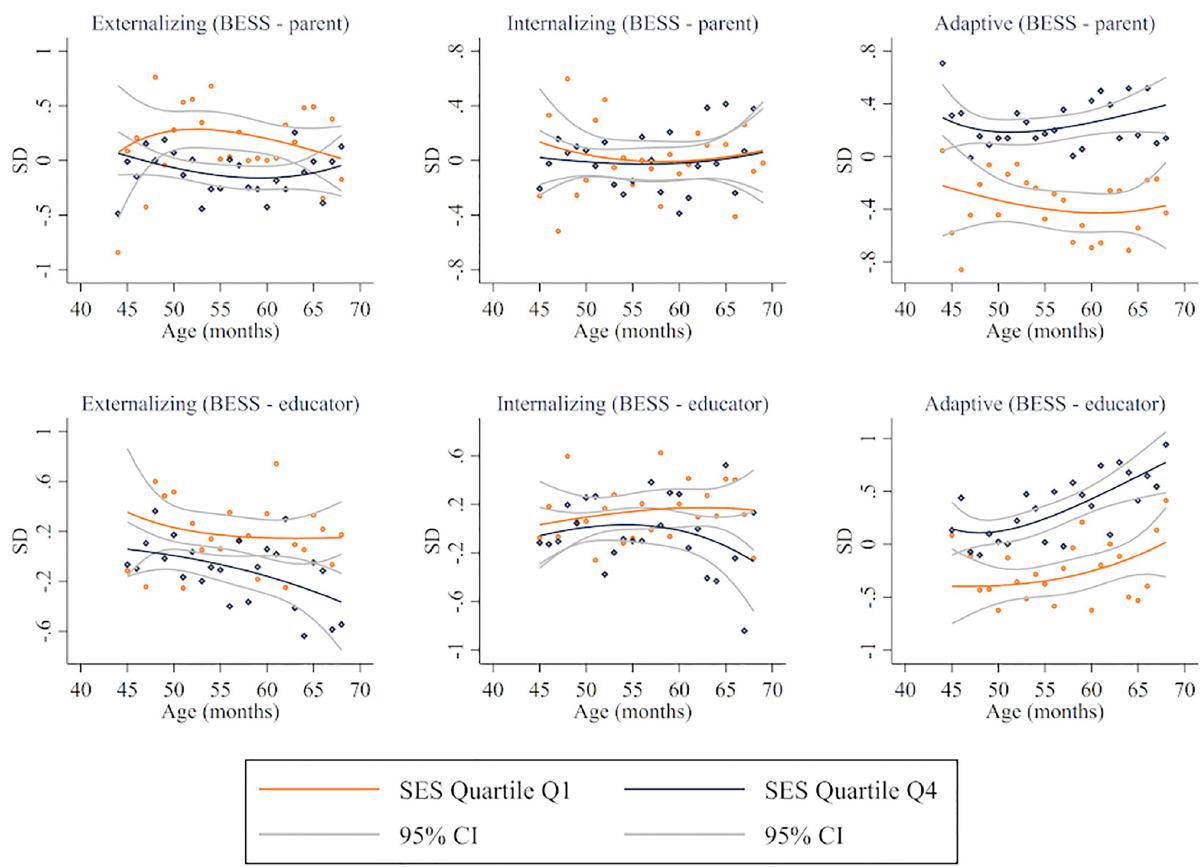
Fig 4. Behaviors by age by SES quartile. Fractional-polynomial plots by developmental